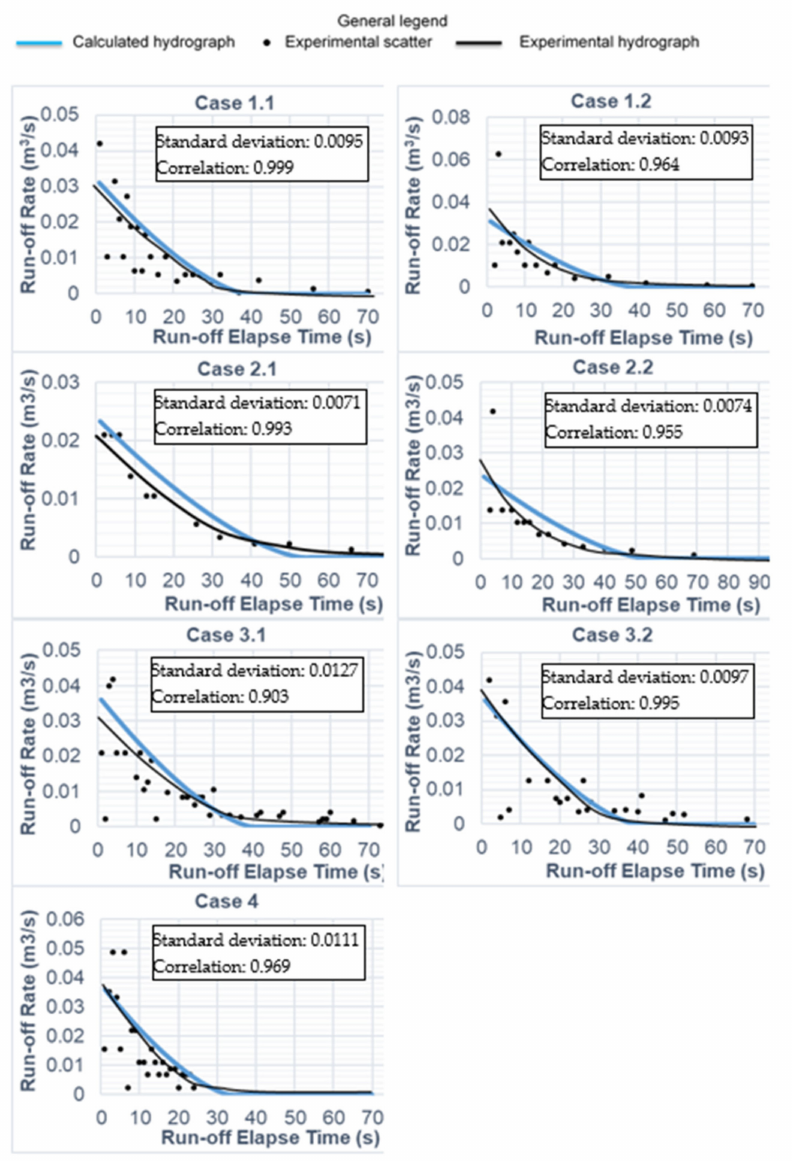
Figure 4. (Case 1–4) Dam-break hydrographs from experimental cases and calculated using Equa- tion